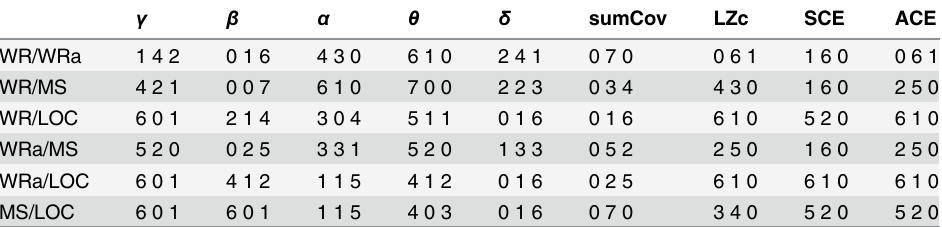
Table 1. Effect size comparison per measure and state pair.